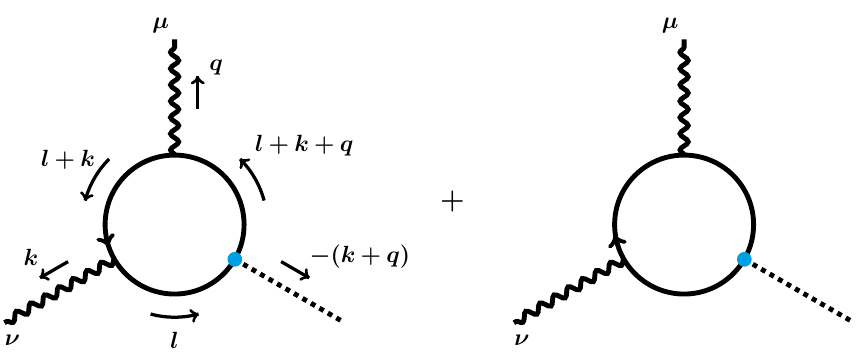
Figure 5 . Diagrams for the vertex function Γ µν ( k, q, m 2